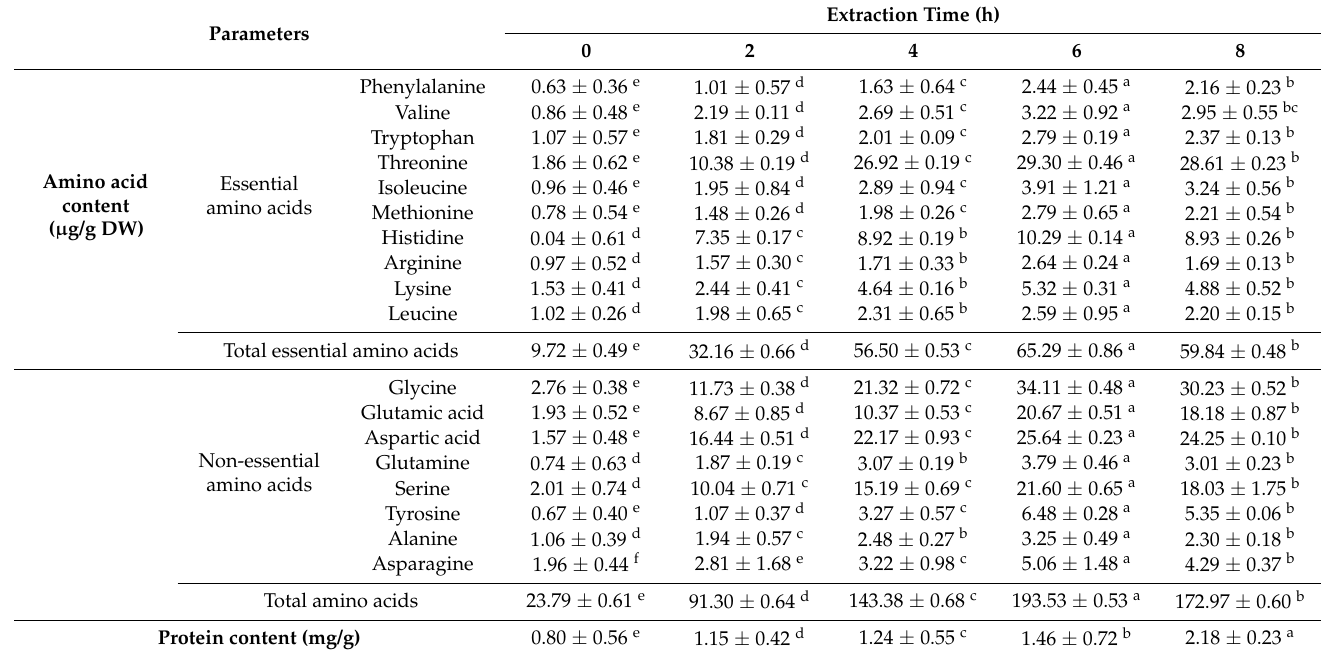
Table 1. The effect of extraction time on the amino-acid content and protein content of SPE in Nangsew strains.